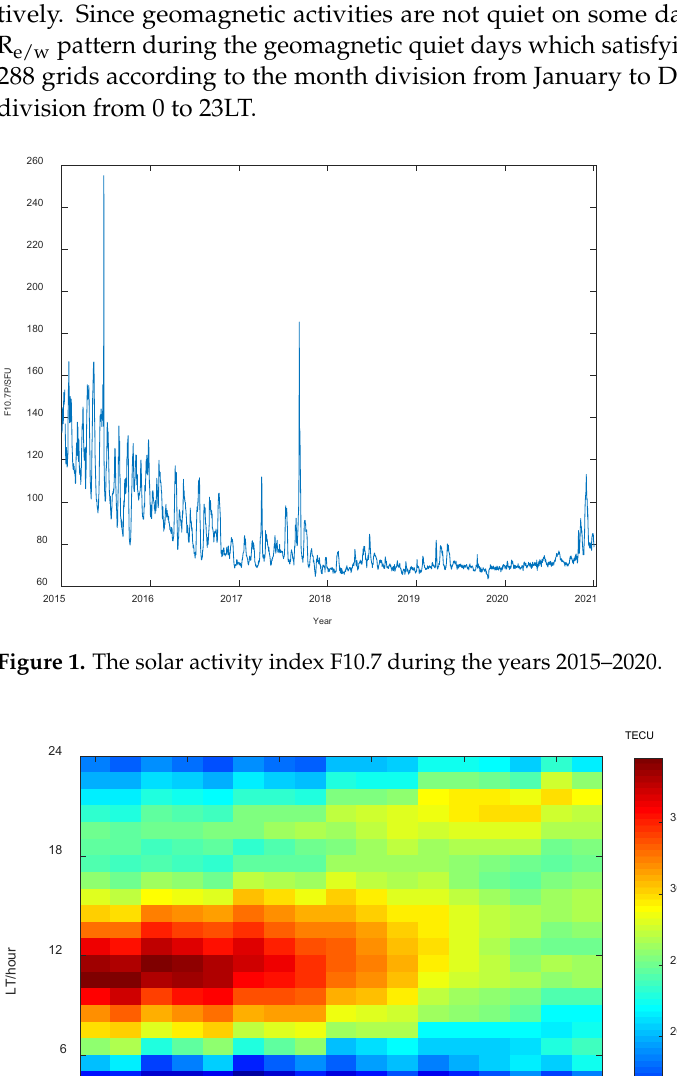
Figure 2. Averaged TEC in the East Asian middle latitude (45°N–50°N) on 10 June 2015.